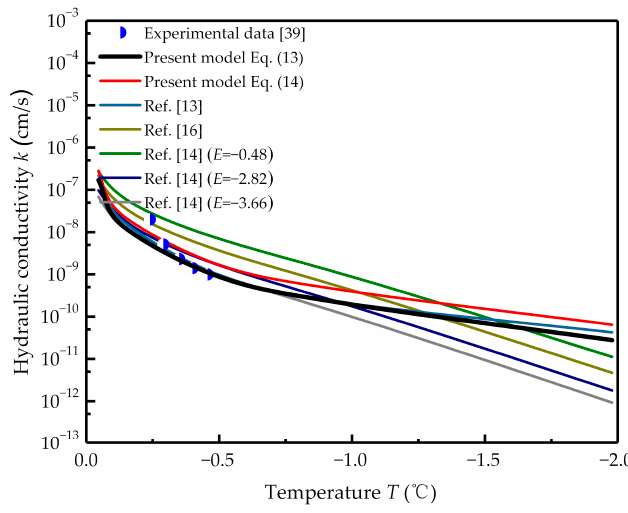
Figure 10. Comparison of the experimental data with different models for Tokoro [39] silt.